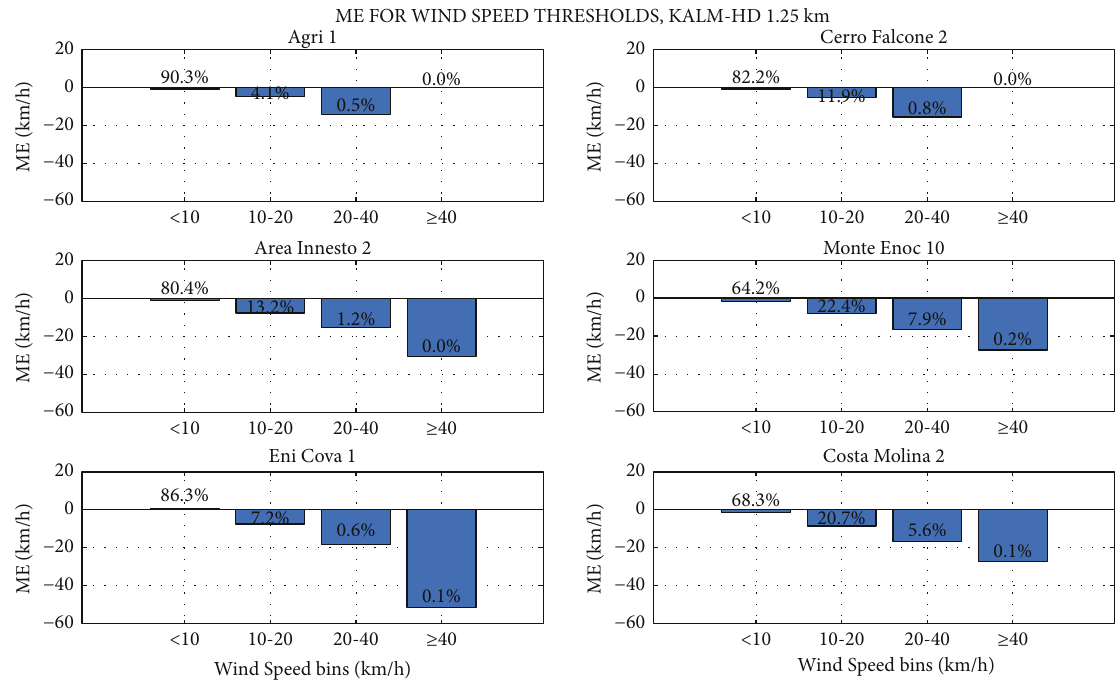
Figure 14: Mean errors for wind speed thresholds in the two years of the observation period over the six weather stations at day +1 as lead time for the KALM-HD model with 1.25km. Values in red are referred to as the percentage of analyzed events in each bin.